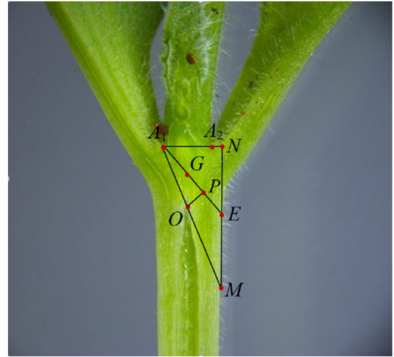
Figure 10. Cutting model of the rootstock